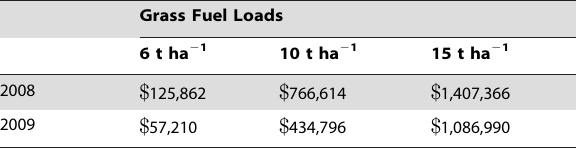
Table 4. Estimated cost of stand-by equipment ( $ 11,442 per day; Table 3) per year, based on the number of days GFDI . 50 in three different FUEL t scenarios (6, 10 or 15 t ha 2 1 ) at three weather stations (Fig.